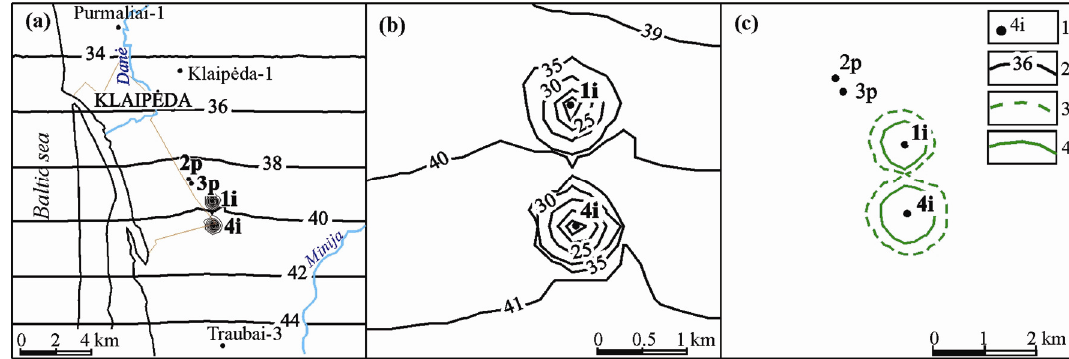
Fig. 6. Schemes of isogeotherms (a), (b) and injected materials migration (c) in Viešvilė aquifer before the stoppage of KDGP in 2007 (model data): 1 – well and its name; 2 – isogeotherm, °C ; per cent of the initial concentration of in- jected material: 3–1%;